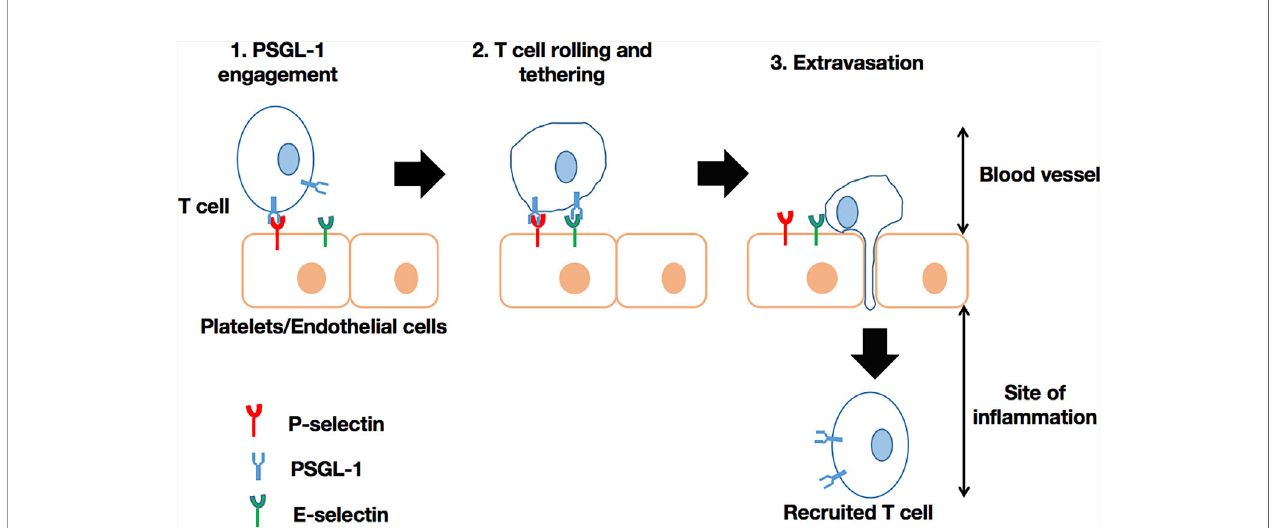
FIGURE 1 | T-cell recruitment via PSGL-1/selectin binding. In the blood vessel, the circulating T-cell is engaged by selectin on platelets (P-selectin) or endothelial cells (P-selectin or E-selectin). Subsequently, the T-cell is able to initiate rolling and the extravasation cascade, leading to its recruitment into the site of in fl ammation, where it can intervene as an effector cell. This process can also take place in the recruitment of other